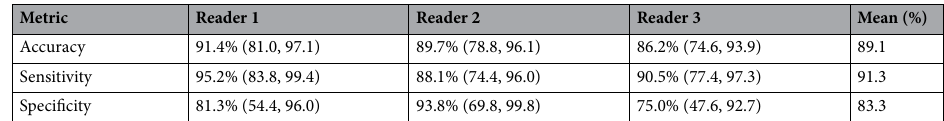
Table 4. Accuracy, sensitivity, and specificity in clinical reading using the BAPL score. Data in parentheses are 95% confidence interval